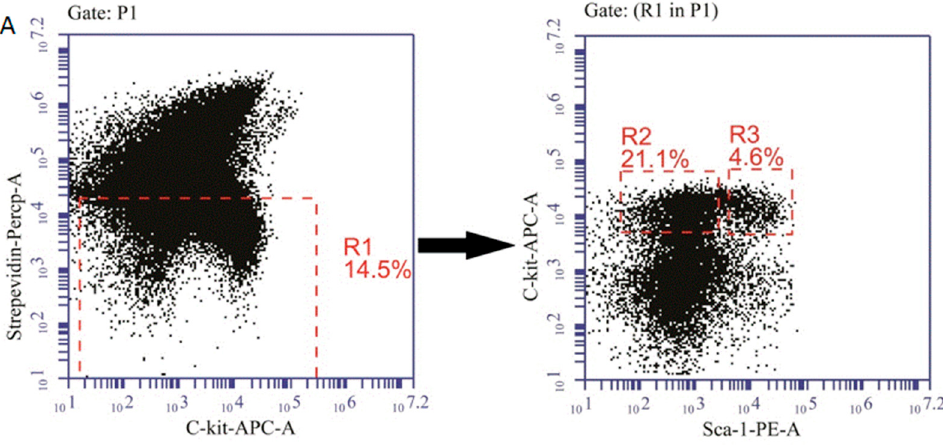
Figure 7. Cont. Figure 7.